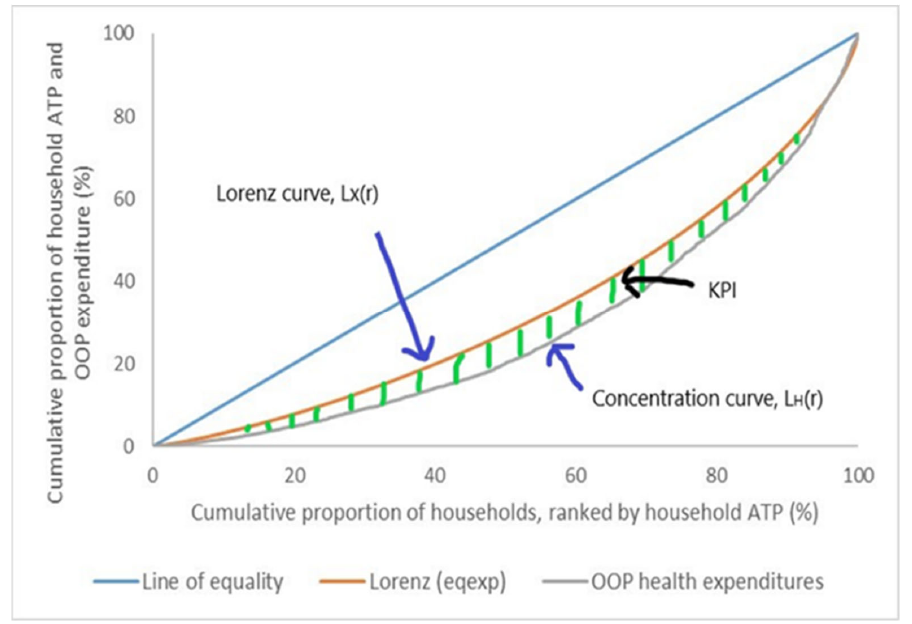
Figure 1. An example graph of progressive concentration curves for OOP payments. Source: author’s own work.